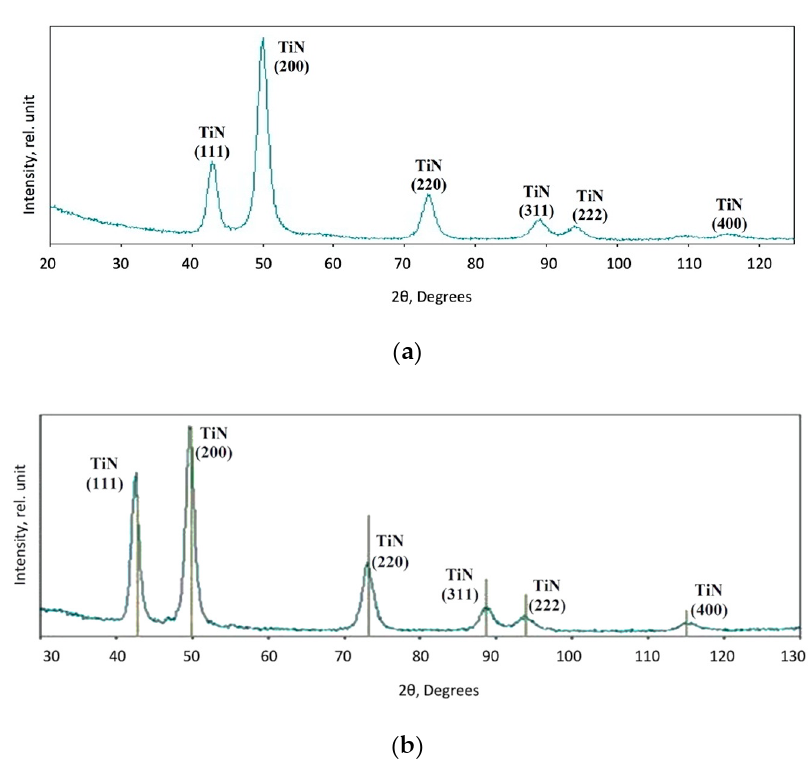
Figure 4. The XRD patterns of the Ti–Al–Cu–N ( a ) and Ti–Al–Ni–N ( b ) coatings.